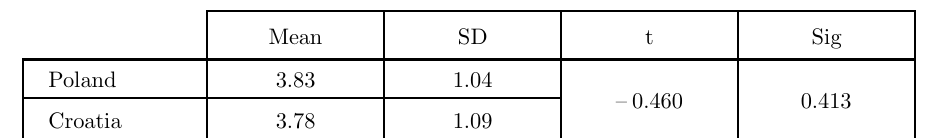
46% in Croatia), followed by B1 (20% in both countries), C1 (16% in Poland and 19% in Croatia), A2 (8% in both countries), C2 (5% in Poland and 3% in Croatia), and A1 (2% in Poland and 4% in Croatia). The coefficients of skewness (– 0.44) and kurtosis (0.50) indicate a normal distribution of this